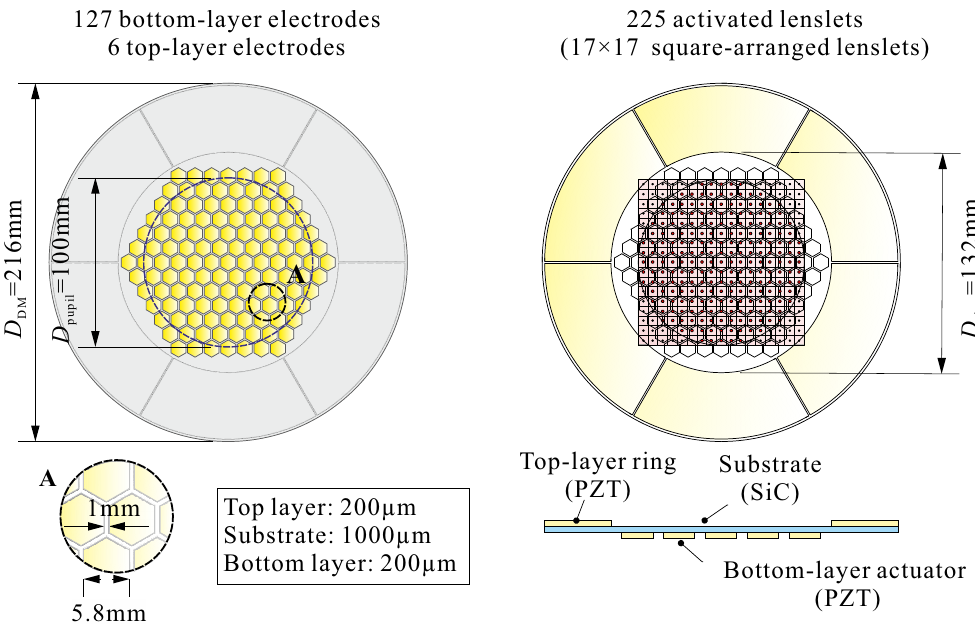
Figure 1. Adaptive optics (AO) mirror baseline configuration used in the simulations. The left side shows the piezoelectric ceramic (PZT) actuator array with honeycomb electrodes, and the right side shows the square lenslet array of the Shack–Hartmann (SH) sensor and the ring of PZT material used for inductive shunt damping